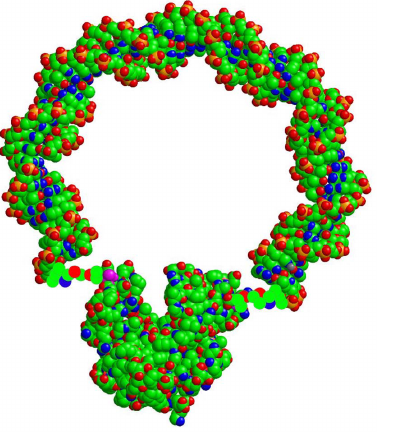
Figure 2. Cartoon of the yeast GK-DNA chimera (in the ‘‘open" state) with the DNA spring attached at the sites 60 and 139. Upon binding of the substrate GMP, the two lobes of the enzyme close on each other. This * 1 nm size conformational motion is a classic example of induced fit. The enzyme structure is PDB 1EX6; the DNA is from the MD simulations of Lankas et al [38], and is kinked in the middle.